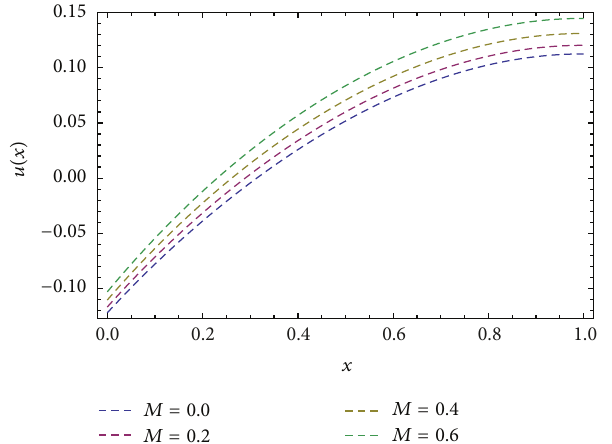
Figure 13: Variation of velocity for various values of slip parameter Λ , by fixing 𝑀 = 0.6 , 𝑚 = 0.2 , and 𝛽 = 1.2 .